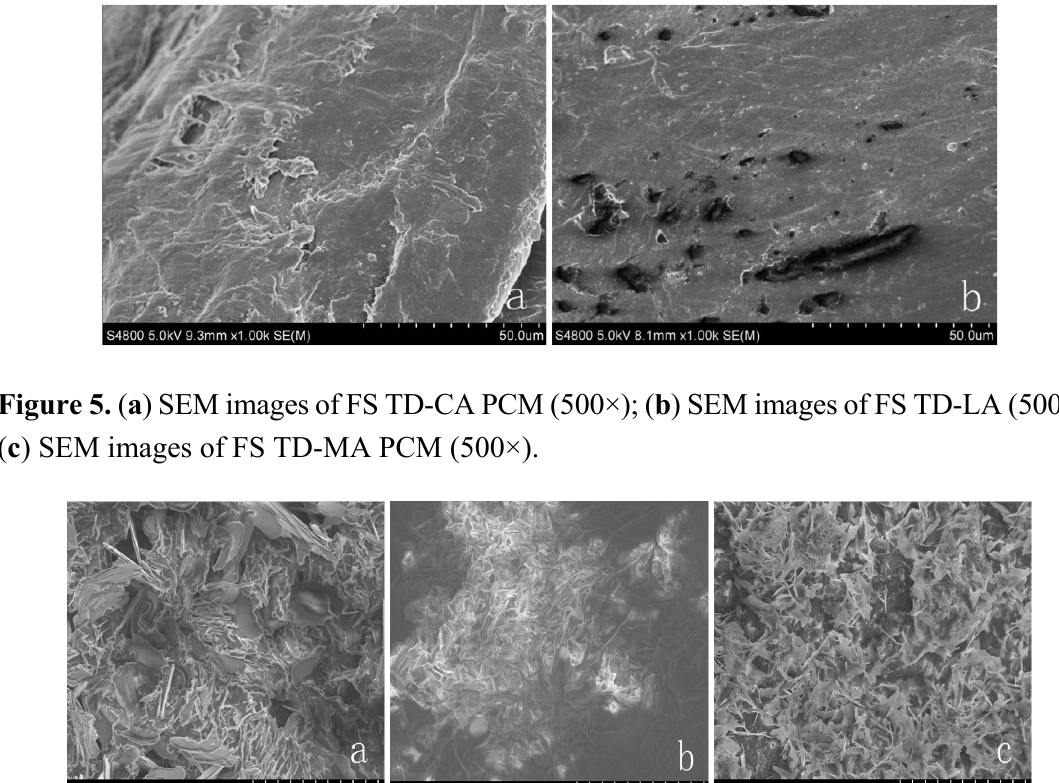
( b ) SEM image of EVA (500×).